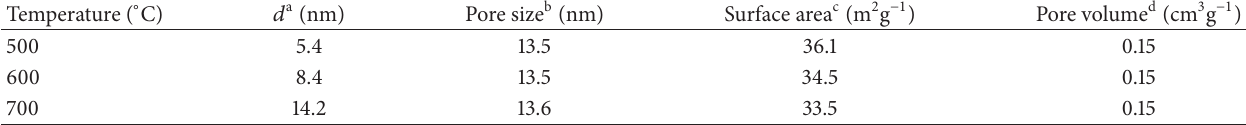
S prepared at different temperatures. 2 4